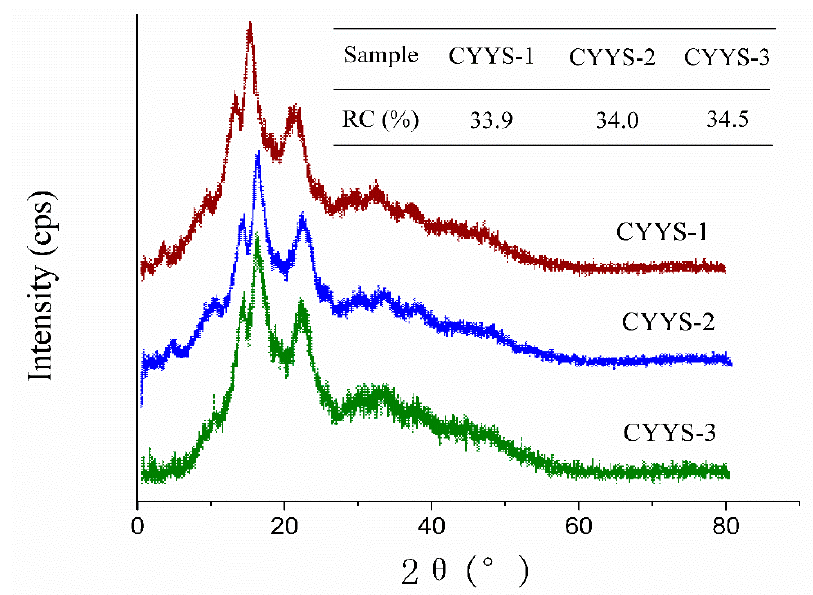
Figure 2. XRD profiles and relative crystallinity (RC) of CYYS-1, CYYS-2, and CYYS-3. CYYS-1, CYYS-2, and CYYS-3 represent NO. 1-, NO. 2-, and NO. 3-Chinese yam starches in Yunlong town, respectively.